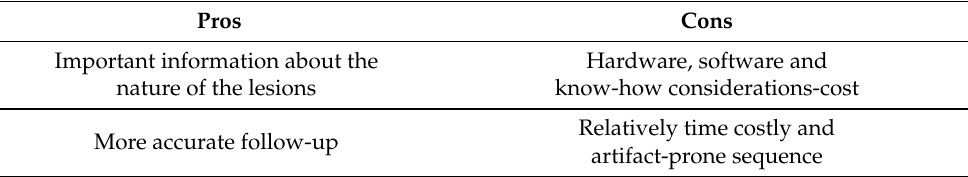
Table 3. Pros and cons of including 1H-MRS in a clinical routine of glioma imaging.